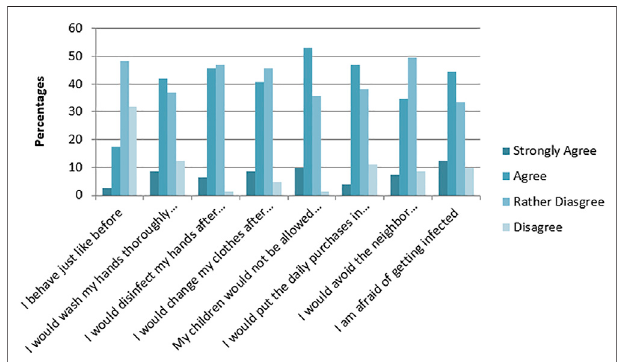
FIGURE 4 | Response to case scenario one.